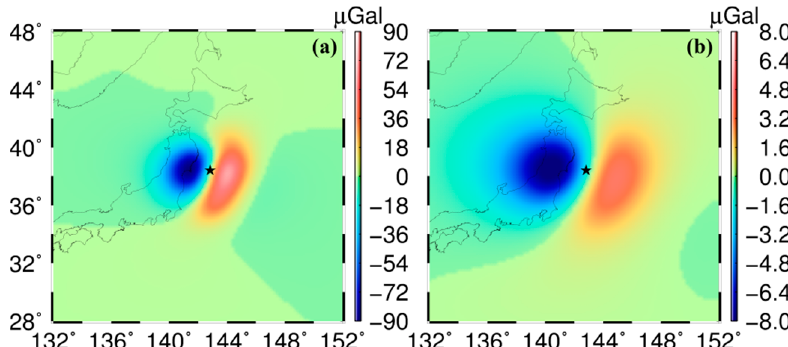
Figure 3. Coseismic gravity changes ( a ) on the Earth’s surface and ( b ) on a sphere with a height of 260 km, when using forward-modeled spherical harmonic coefficients up to d/o 250 with a Gaussian filter applied (radius of 110 km). The units are μ Gal.